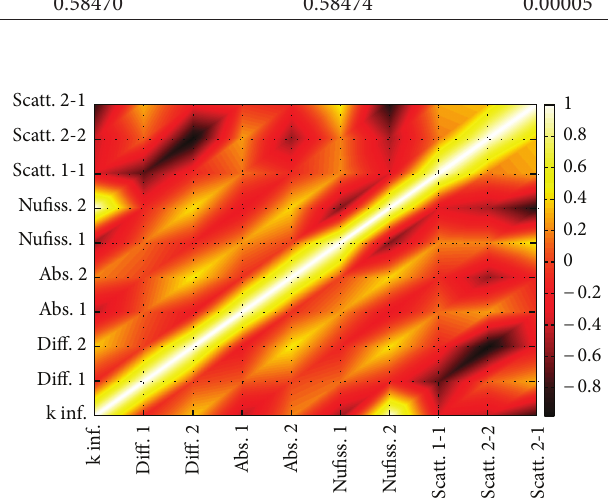
F 13: Correlation matrix of the output parameters based on JENDL-4 data.